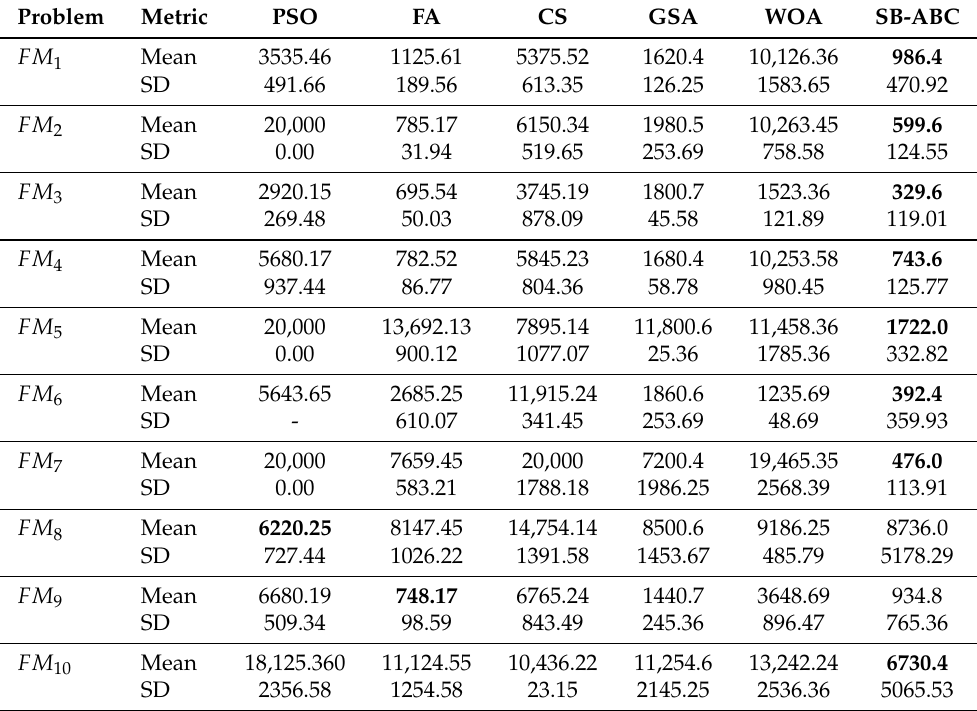
Table 7. Comparison results of the PSO, FA, CS, GSA, WOA and SB-ABC for the FM 1 – FM 10 minimax